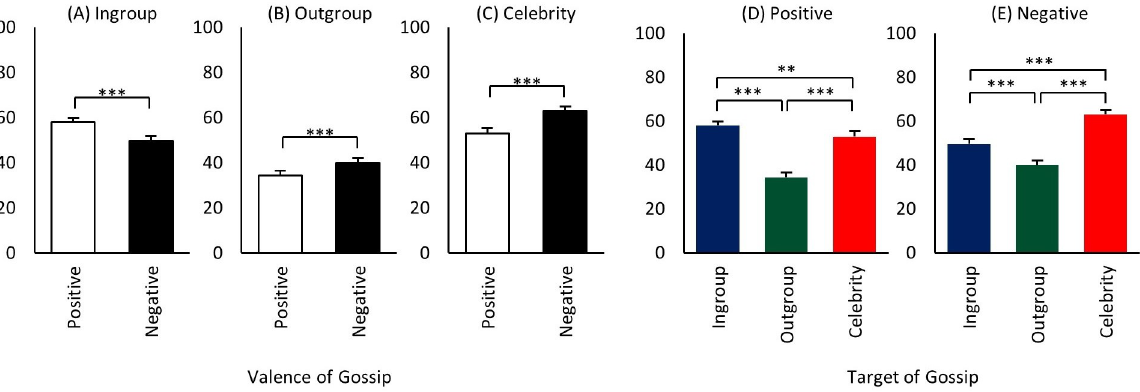
PLOS ONE | https://doi.org/10.1371/journal.pone.0269812 July 6,